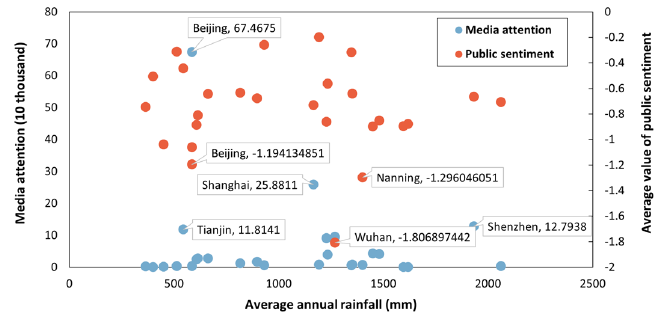
Figure 4. The relationship between news media responses towards urban floods and average annual rainfall in SCP pilot cities.